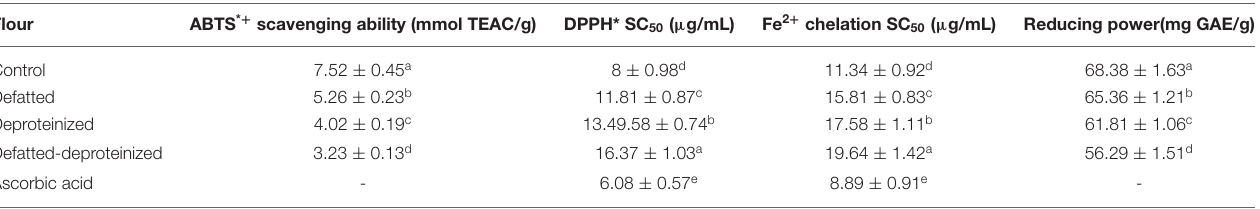
Results are means ± SD of triplicate determinations. Along the same column, values having different superscript letters vary significantly (p < 0.05). SC 50 : extract concentration that scavenged 50% of DPPH * ; TEAC, trolox equivalent antioxidant capacity; GAE, gallic acid equivalent. followed by DP, DF, and DF-DP flours. The